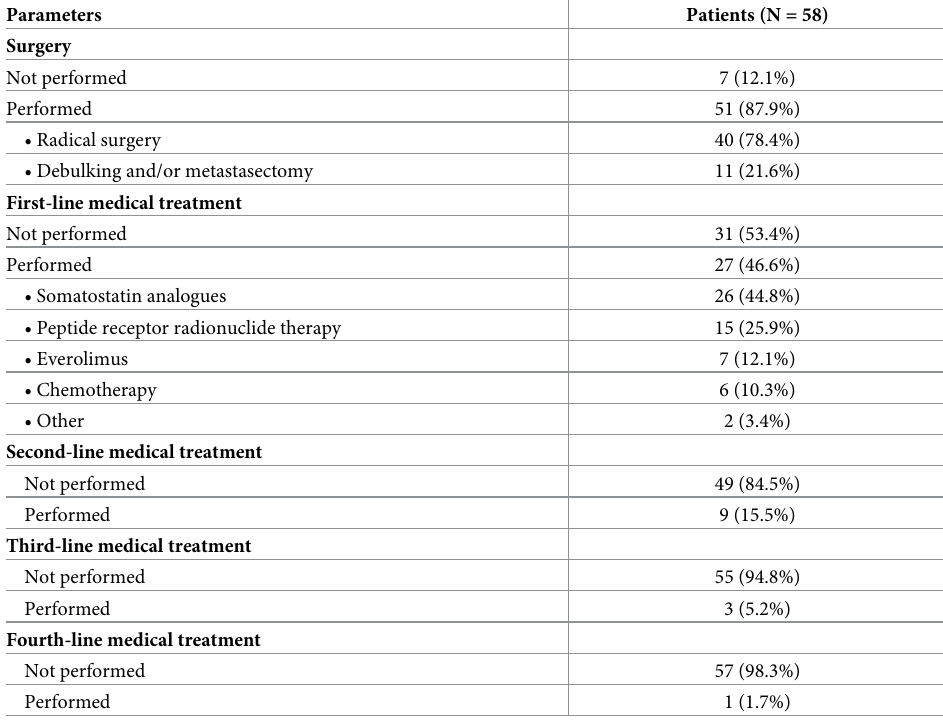
Table 2. Surgical and medical history of the enrolled